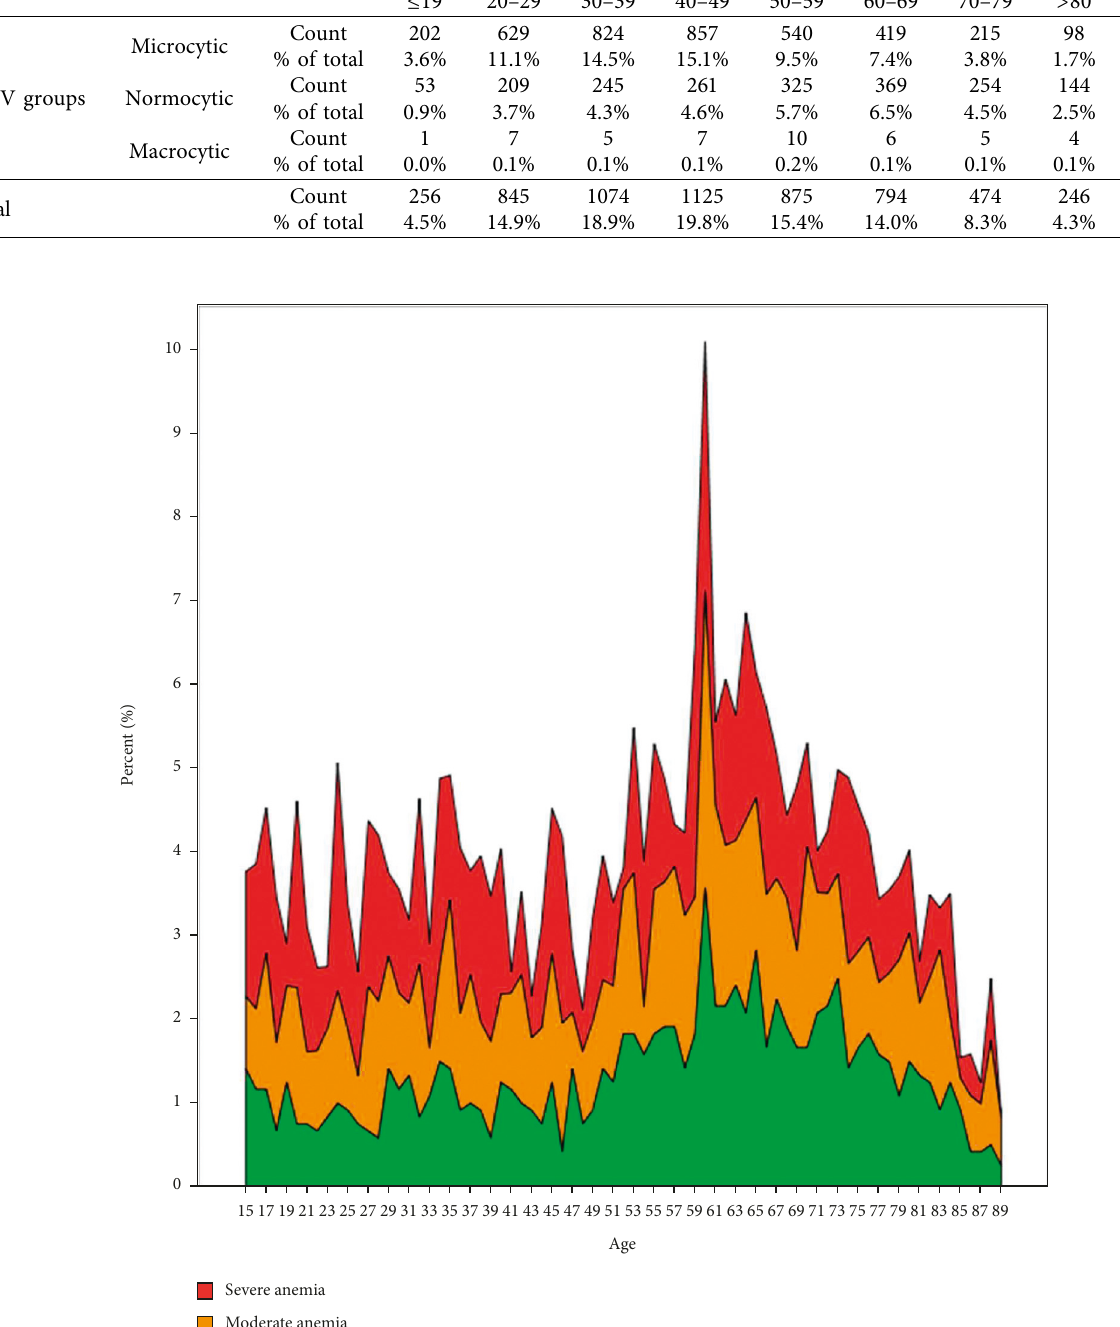
Figure 4: Age-wise prevalence of mild, moderate, and severe anemia in